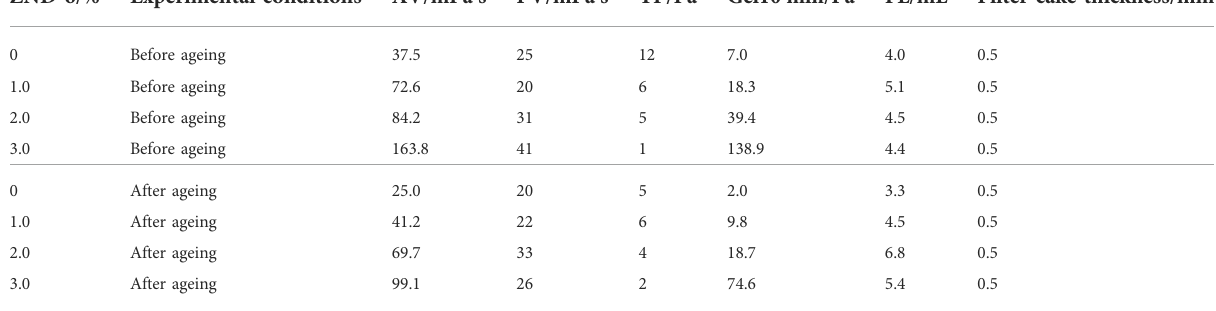
TABLE 3 Compatibility of ZND and Polymer Drilling Fluid (150 ° C for 16 h aging).